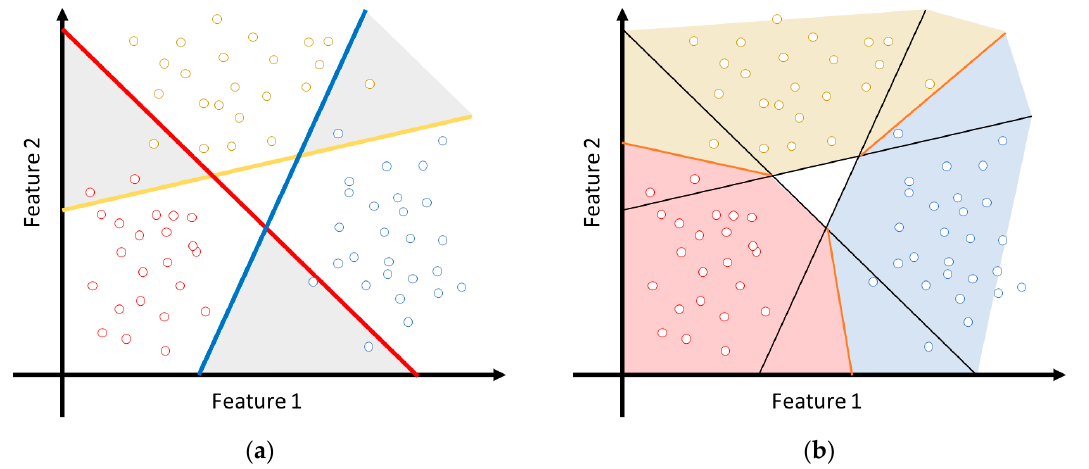
Figure 8. ( a ) Relationship between samples in the transition area and the corresponding category hyperplane; ( b ) Relationship between the improved hyperplane and the corresponding category samples.